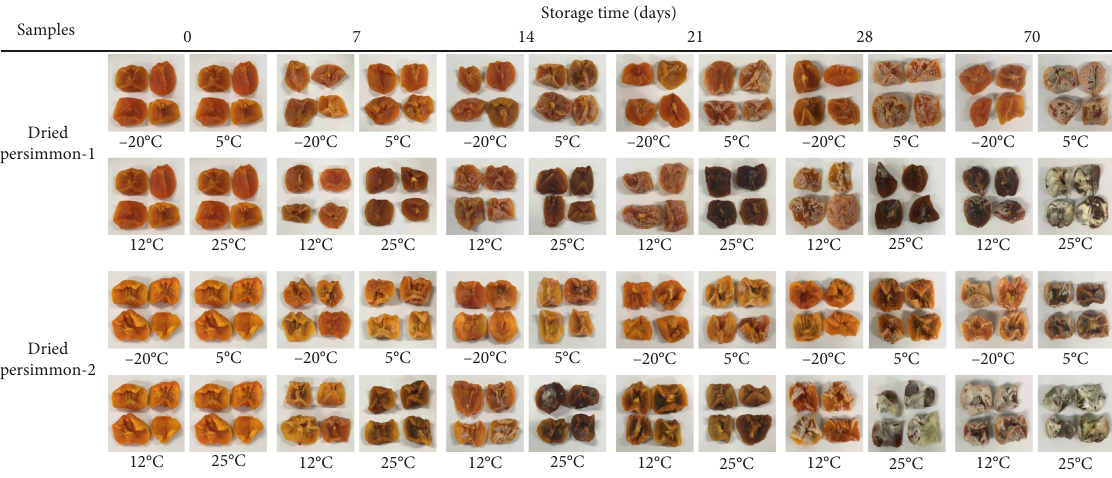
Figure 3: Digital photographs of dried persimmon-1 and dried persimmon-2 during storage at different temperatures ( − 20, 5, 12, and 25 ° C) for